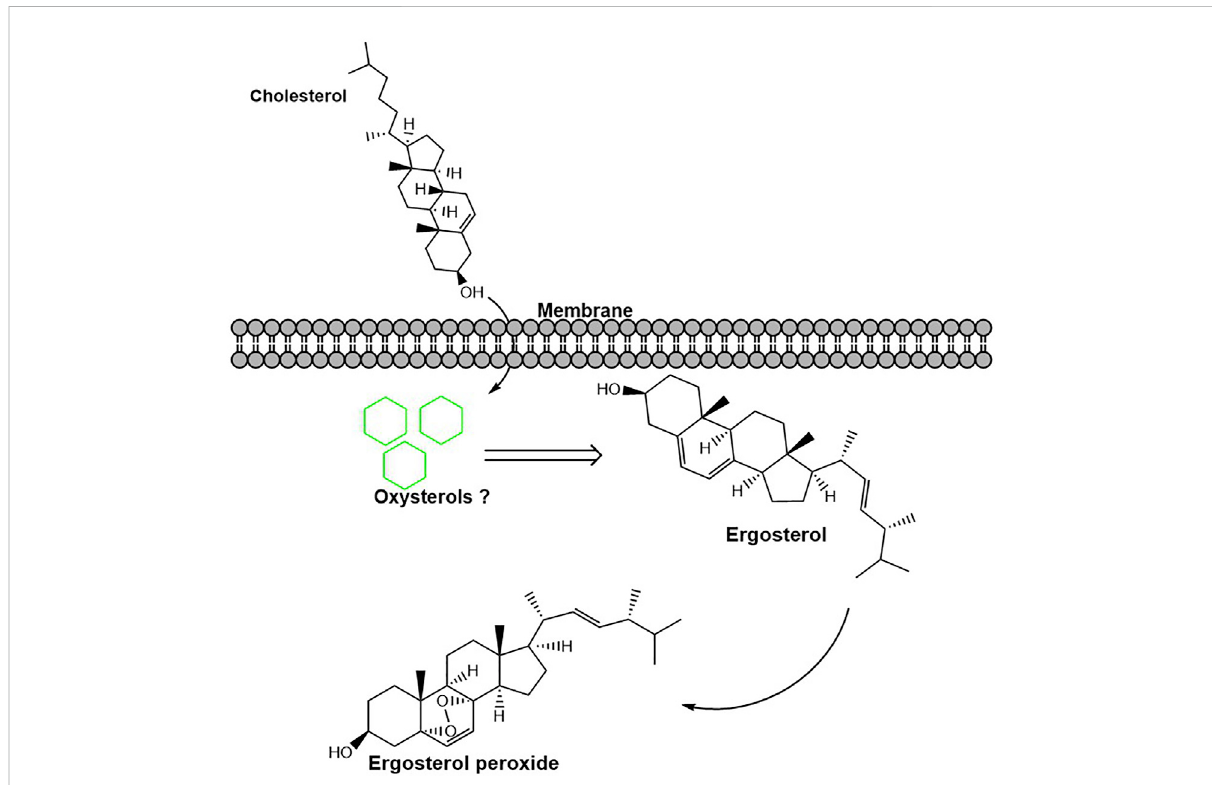
FIGURE 8 Cholesterolutilizationby A.oryzae canpromotetheconversionofergosteroltoergosterolperoxide.Aftercholesterolwasutilizedby A.oryzae , some cholesterol was converted into other metabolites. This process promotes the conversion of ergosterol to ergosterol